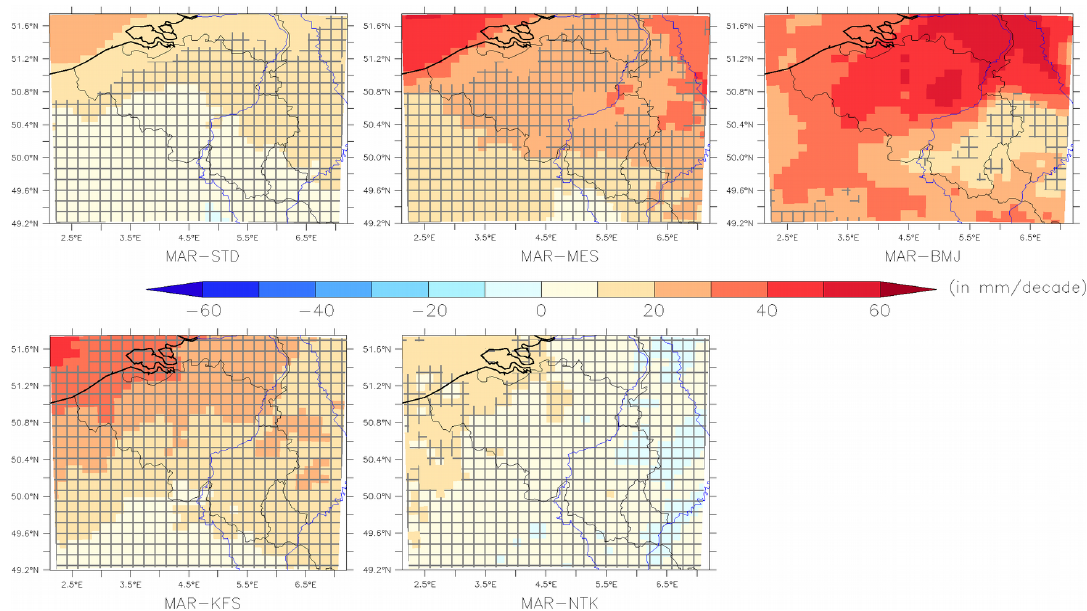
Figure 8. Trends in annual convective precipitation simulated by MAR for each experiment over 1987–2017 in mm/decade. Crosshatched pixels indicate statistically non-significant trends.